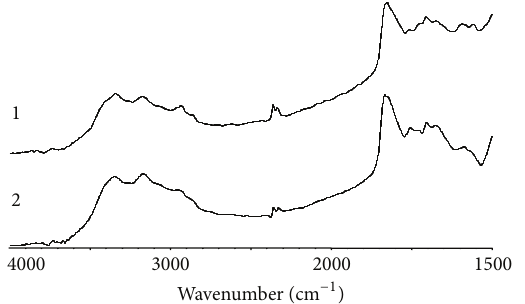
Figure 5: FTIR spectrum of arginine spot (trace 1) on a narrow band TLC plate. For comparison, a reference FTIR spectrum of pure arginine (trace 2) is also